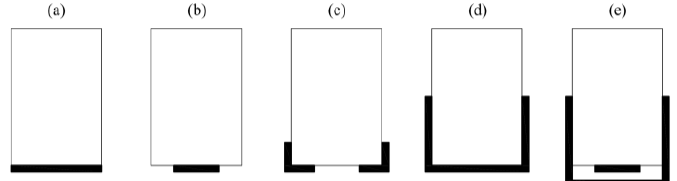
Figure 4. Methods of strengthening solid wood with FRP outside—( a ) full-width, ( b ) half-width, ( c ) angles, ( d ) U-shaped, ( e ) cumulative: half-width with U-shaped. Another way method is to fold the composite onto the vertical planes of the